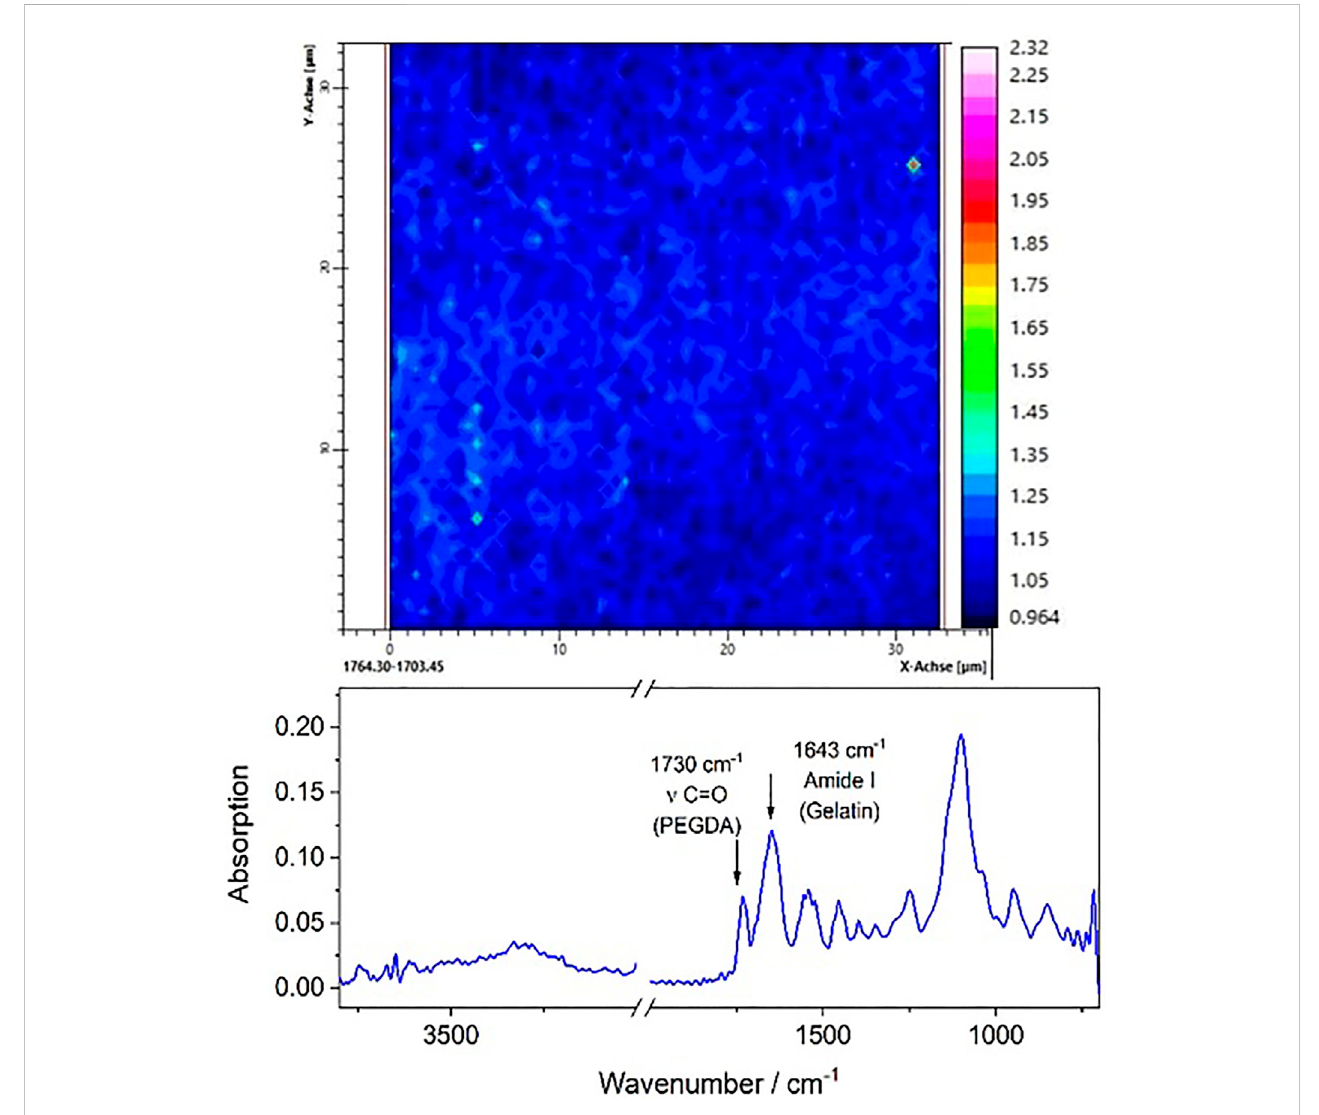
FIGURE 8 Infrared specrtal image of P26G4 hydrogels irradiated with 6 kGy. The bottom fi gure shows a represenative IR spectrum with characteristic bands of PEDGA and gelatin,